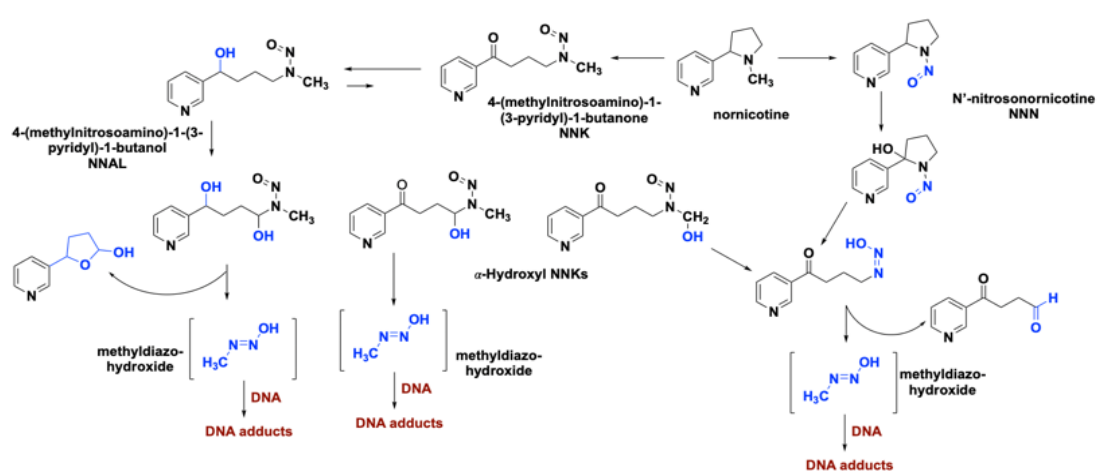
Figure 2. Formation of the DNA adducts by benzo[a]pyrene (B[a]P) and 4-aminobiphenyl (4-ABP).